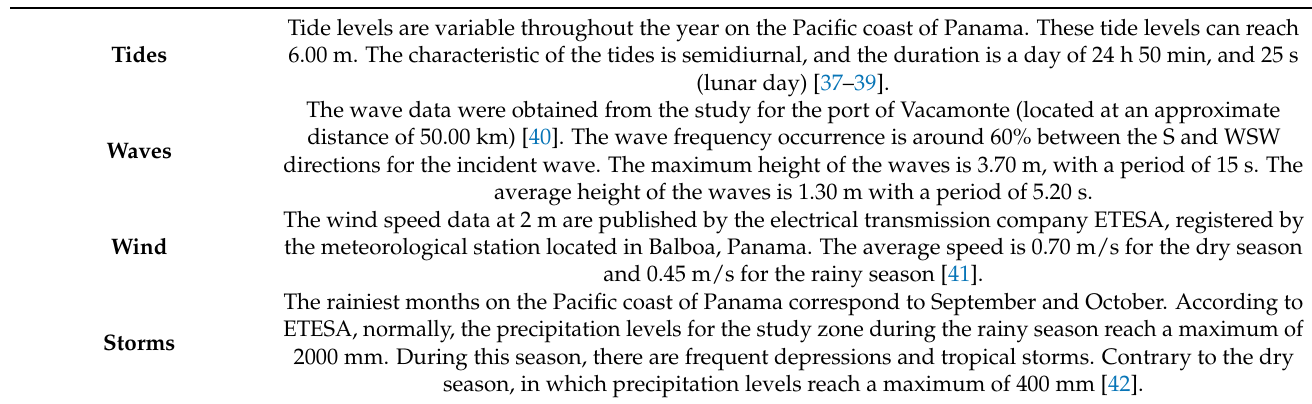
Table 1. General information about the study zone.